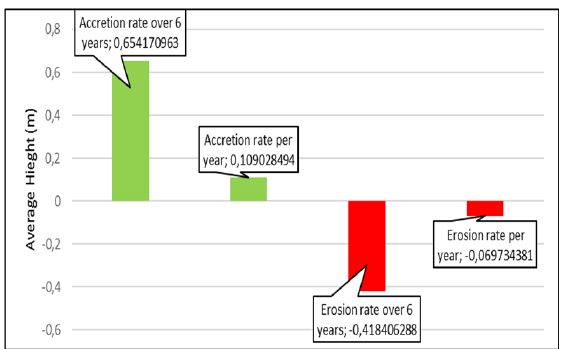
Figure 5. Chart showing the erosion/accretion rate changes in the Oualidia lagoon between 2006 and 2012 .